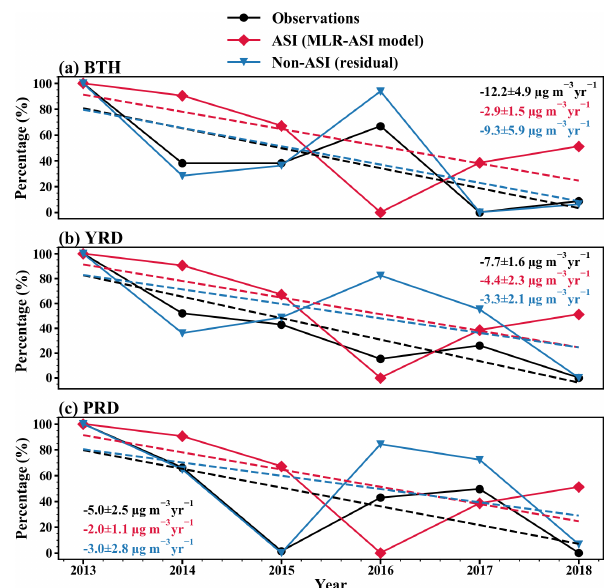
Figure 3. Same as Fig. 2 but for MLR-ASI analysis.